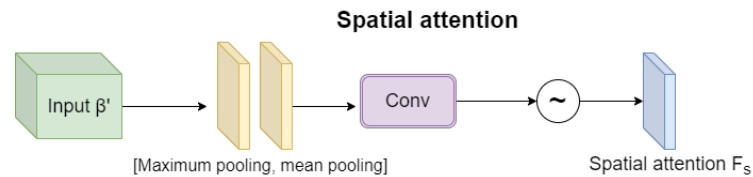
Figure 6. Spatial attention